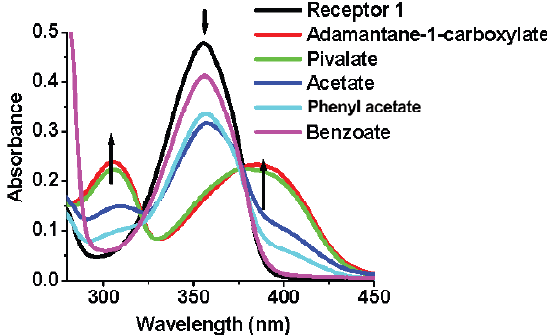
Figure 38. Change of absorption spectra of 36 upon addition of different tetrabutylammonium carboxylate salts (8 equiv) in chloroform.(adapted from ref. 85).